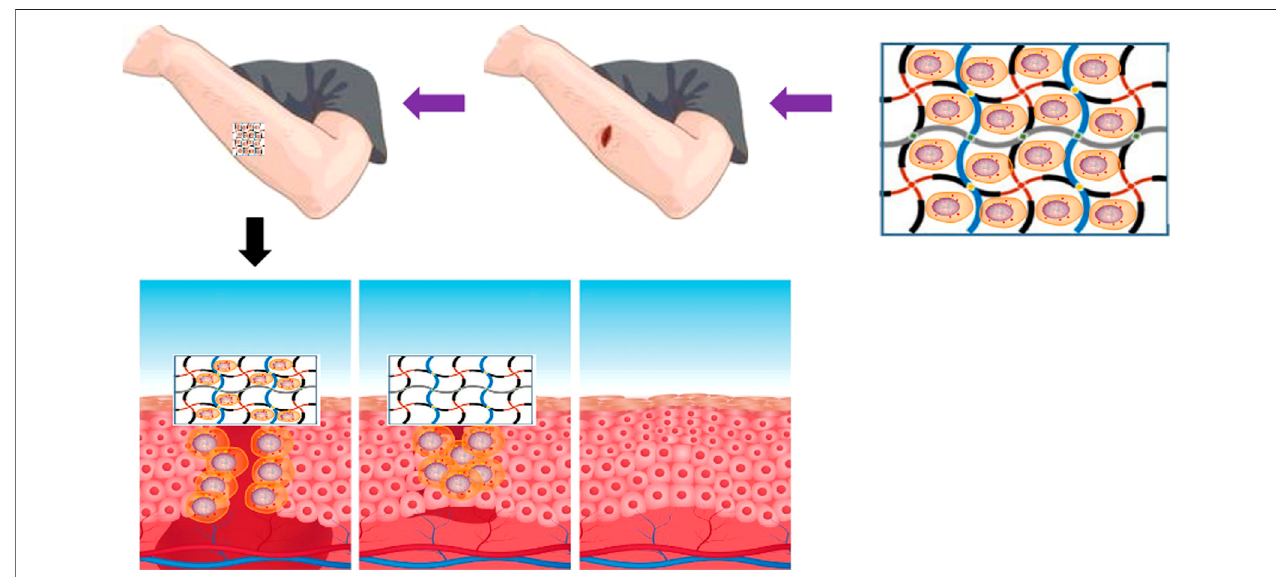
FIGURE 4 | Schematic diagram of wound healing promoting effect of BC